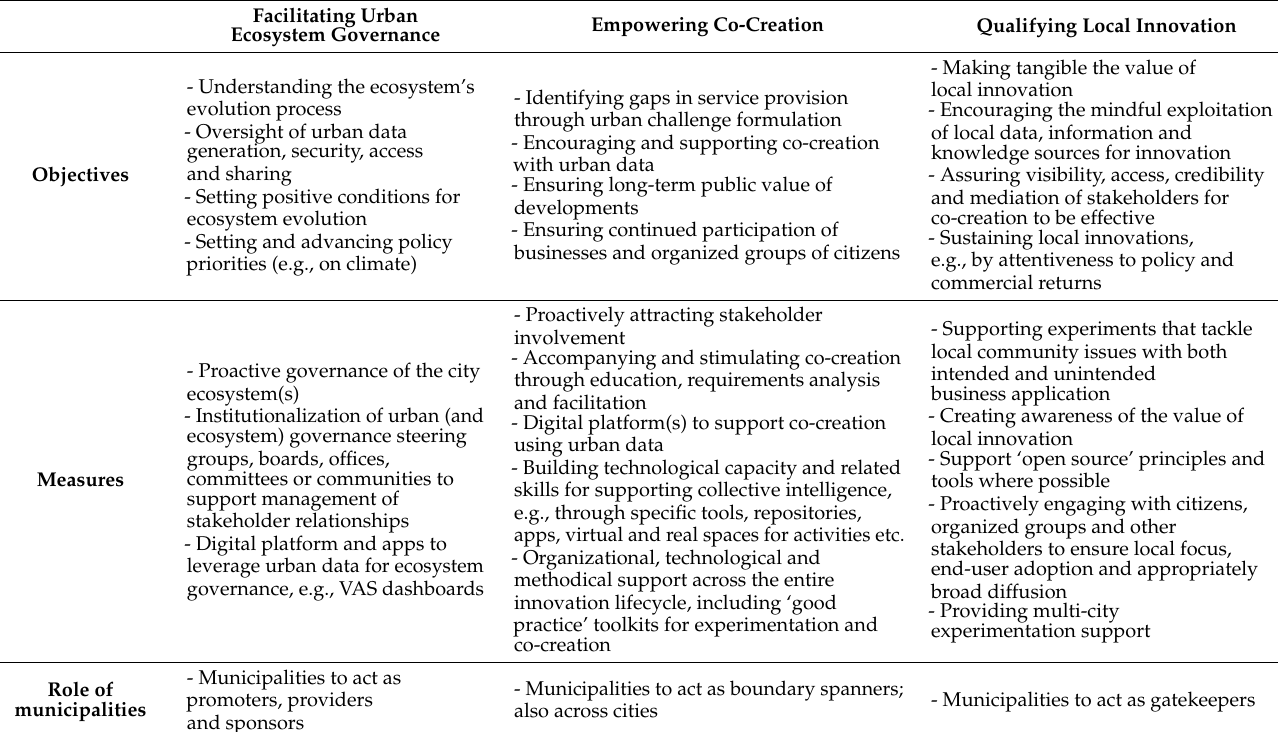
Table 1. Aspects and measures supporting set-up of urban experimentation platforms as indicated by case